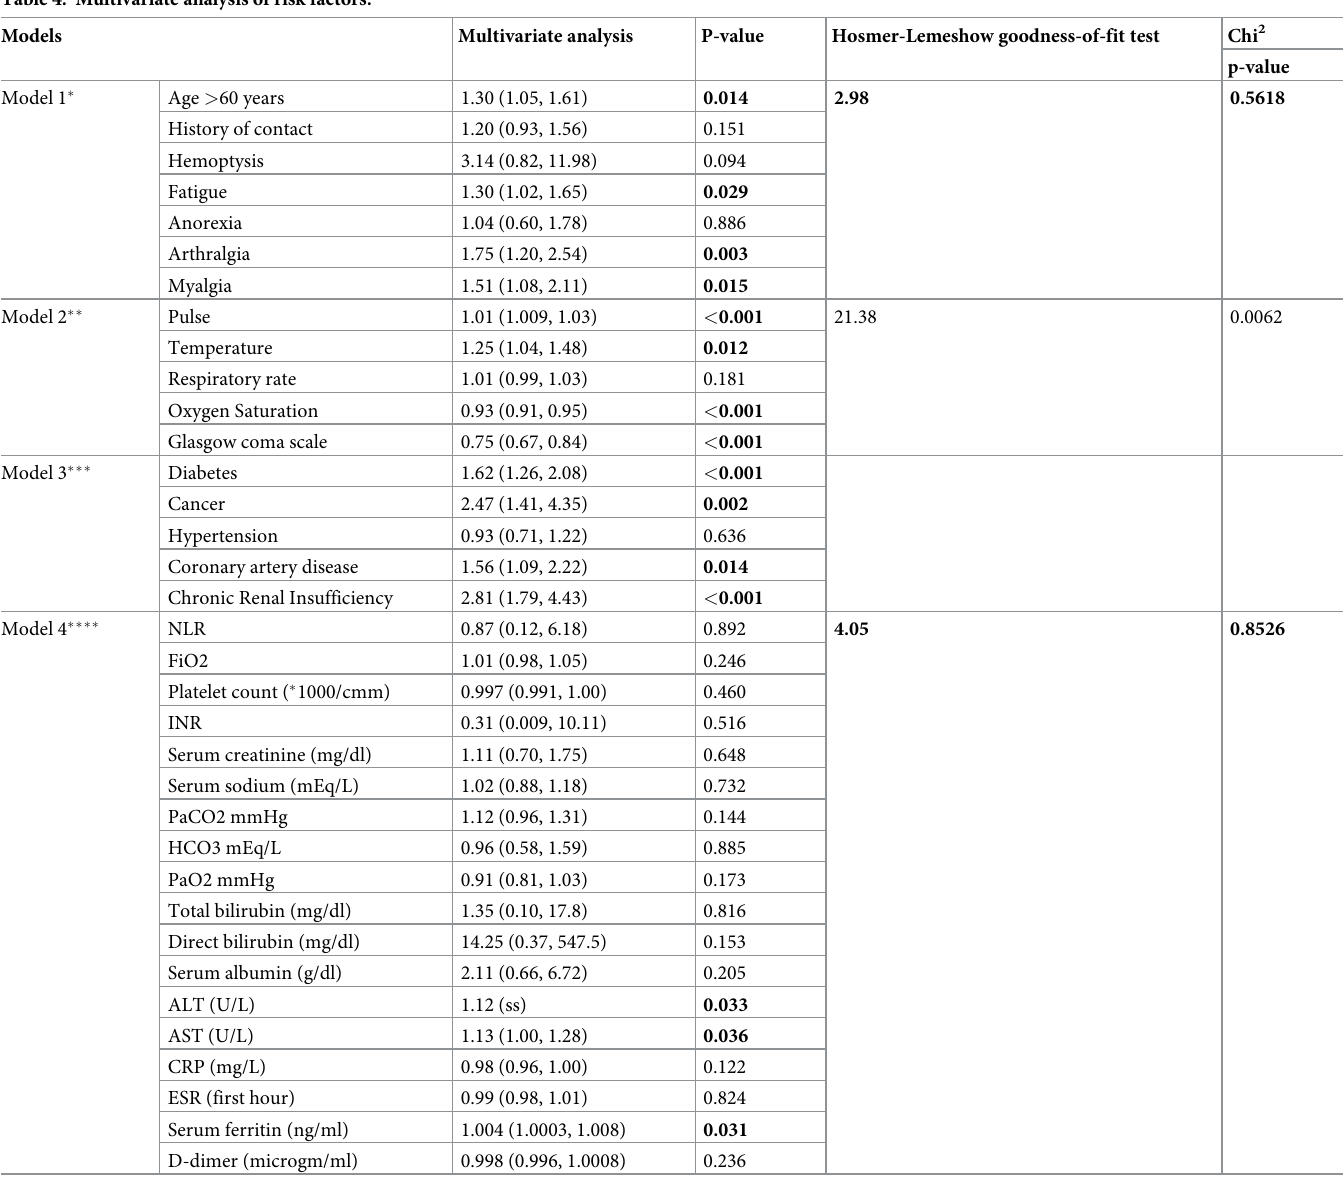
Table 4. Multivariate analysis of risk